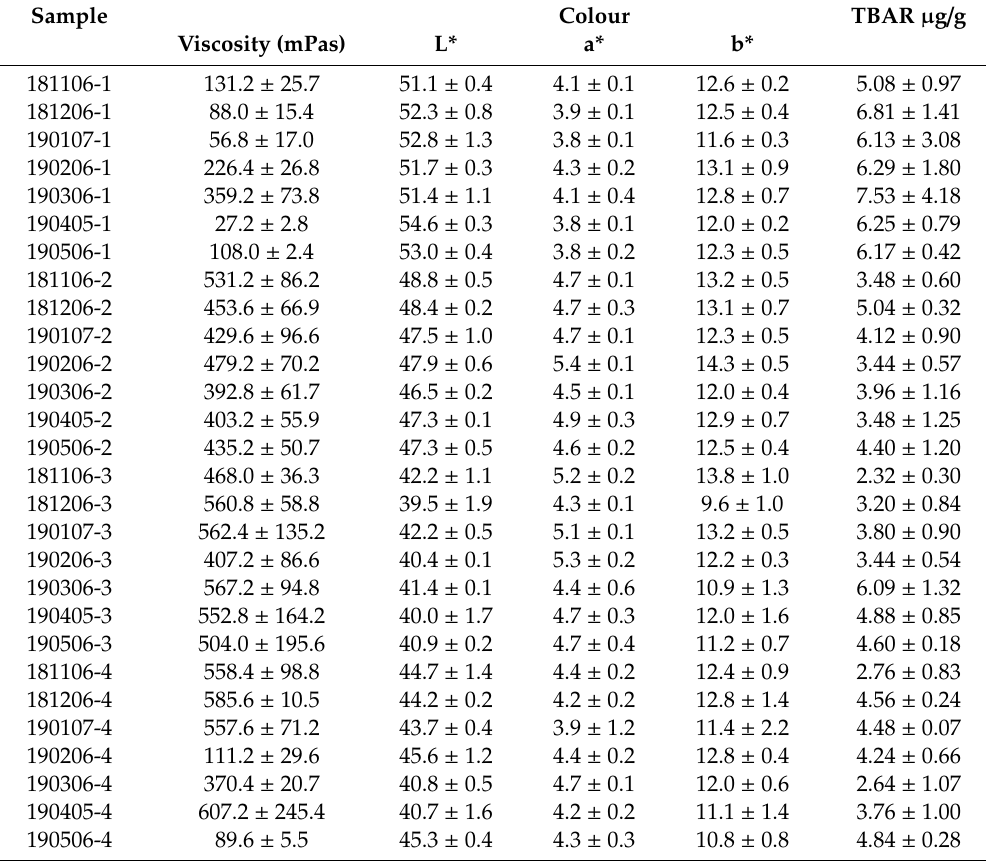
Table 5. Mean values and standard deviations of viscosity, colour (L*, a* and b*) and TBAR. Sample Colour TBAR µ g /